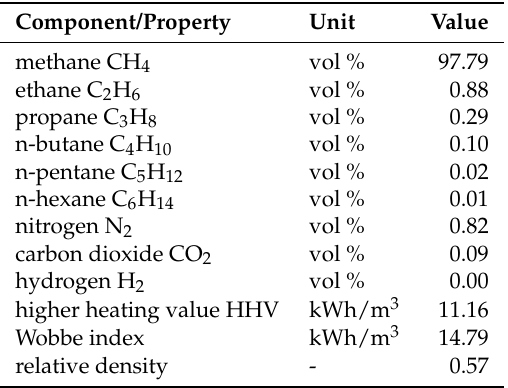
Figure 1. Impact of H 2 on natural gas (Russia H) with different regulatory limits; after [5]; ( a ) specification limits according to Austrian regulations ÖVGW G31 [4]; ( b ) specification limits according to European regulations EASEE [6]. Table 1. Initial composition and gas properties of natural gas type Russia